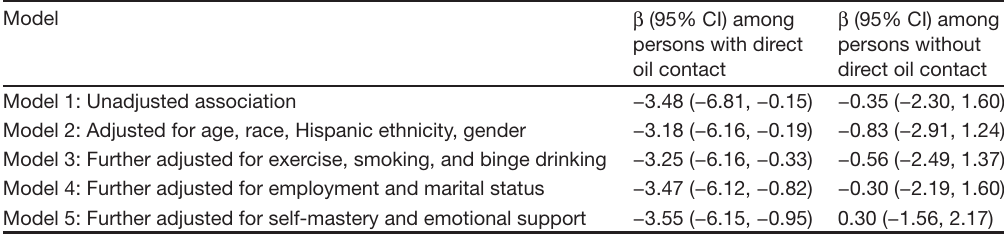
Table 5. Differences in anxiety ( β ) between individuals participating in oil spill cleanup activities compared to individuals not participating in oil spill cleanup activities, among individuals with direct contact with oil, in communities participating in the GSPS